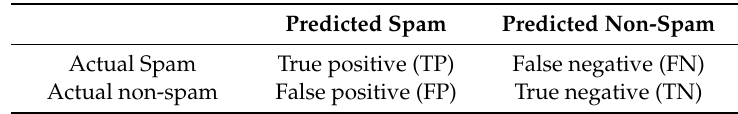
Table 3. Confusion